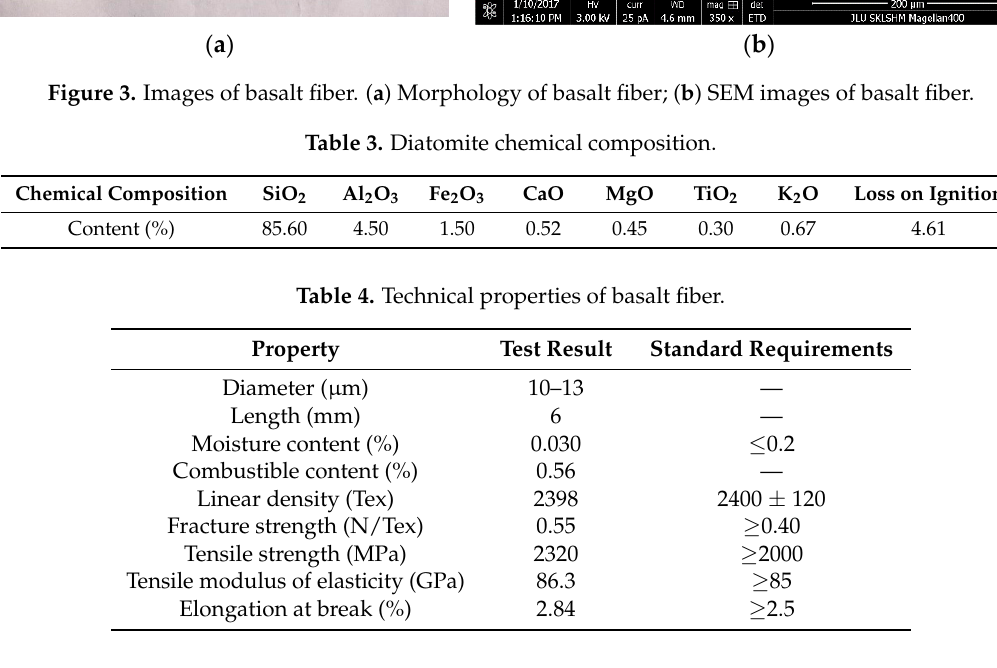
Table 5. Experimental design of asphalt mixtures. AM: control asphalt mixture; DAM: diatomite modified asphalt mixture; BFAM: basalt fiber modified asphalt mixture; DBAFM: diatomite and basalt fiber compound modified asphalt mixture.